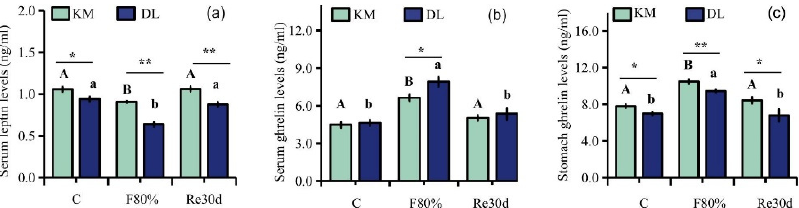
Figure 3. Serum leptin ( a ), serum ghrelin ( b ), and stomach ghrelin concentrations ( c ) in E. miletus under food restriction. Different letters denote significant differences among treatments in the same region, capital letters refer to the Kunming region, and lowercase letters refer to the Dali region. * p < 0.05 and ** p < 0.01 Kunming versus Dali on the same day.